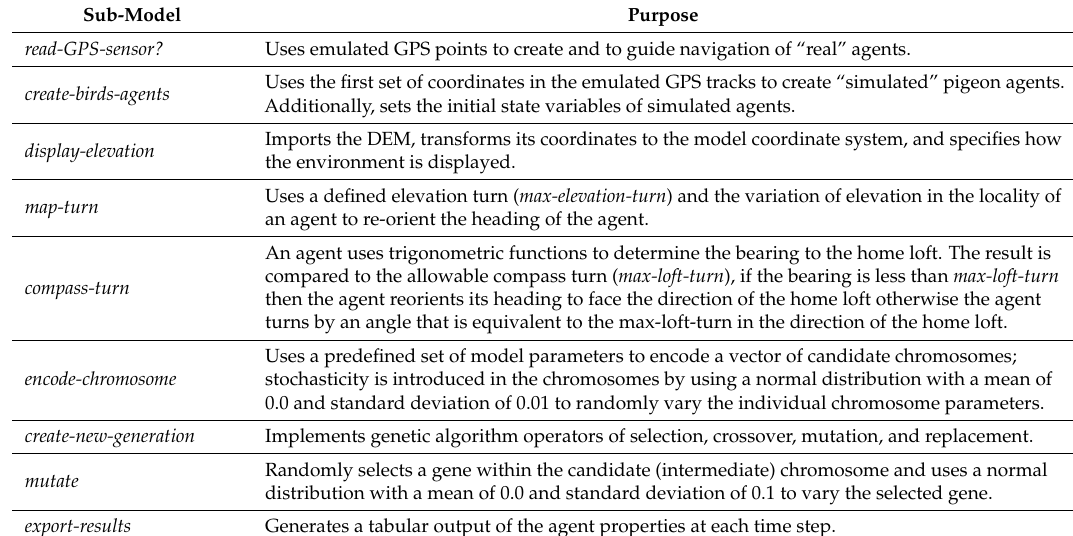
Table 2. Individual sub-models and their purposes.